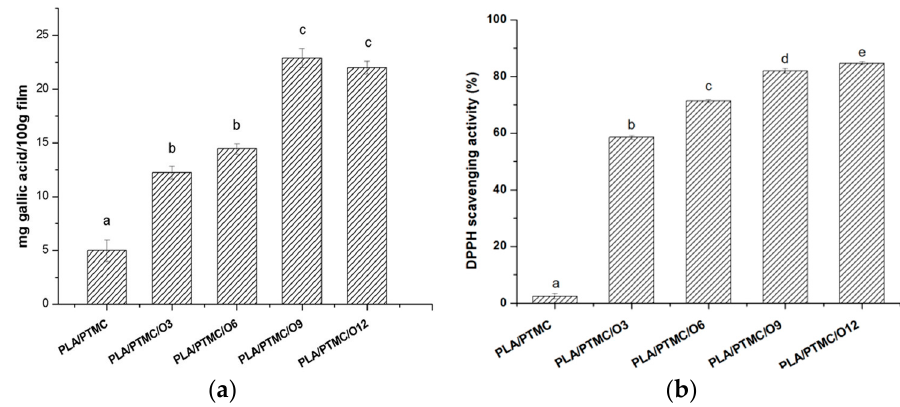
Figure 5. ( a ) Total phenolic content of PLA/PTMC, PLA/PTMC/O3, PLA/PTMC/O6, PLA/PTMC/O9 and PLA/PTMC/O12; ( b ) DPPH scavenging activity of PLA/PTMC, PLA/PTMC/O3, PLA/PTMC/O6, PLA/PTMC/O9 and PLA/PTMC/O12. Values followed by different letters (a–e) were significantly different ( p < 0.05).